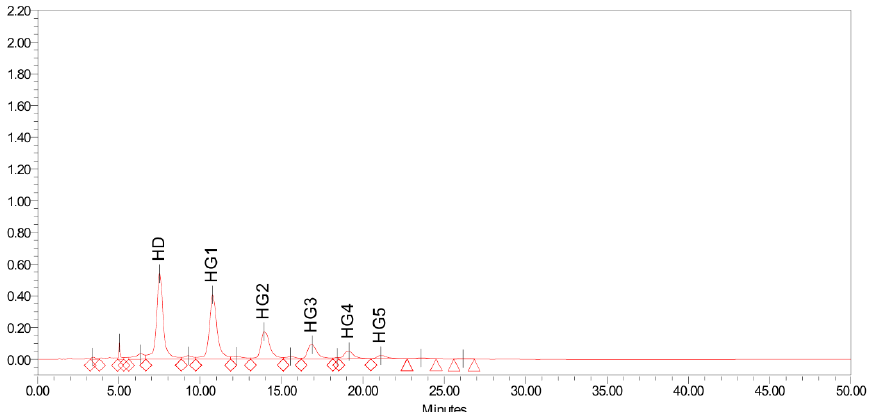
Figure 2. HPLC profiles of hesperidin glucosides synthesized during enzymatic transglycosylation. The x- and y-axis represents the retention time (min) and arbitrary unit (AU), respectively. Abbreviation, HD; hesperidin, HG1; hesperidin mono-glucoside, HG2; hesperidin di-glucoside, HG3; hesperidin tri-glucoside, HG4; hesperidin tetra-glucoside, HG5; hesperidin penta-glucoside.